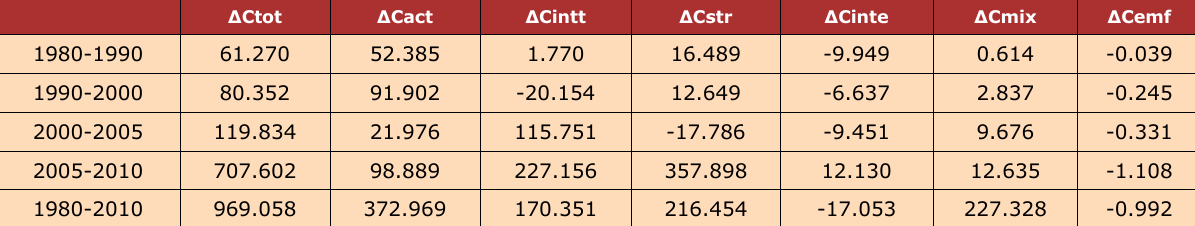
Table 4. Additive decomposition of CO 2 emission in logistics